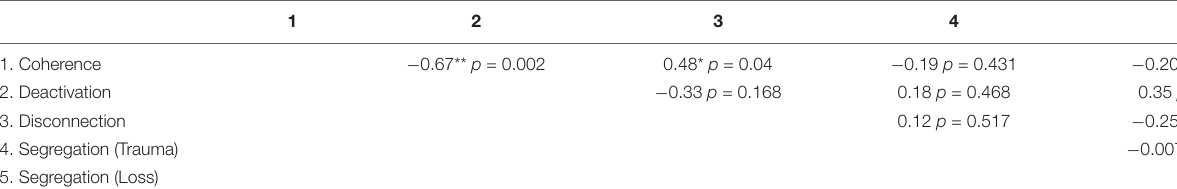
TABLE 3 | Spearman’s correlations (r s ) of coherence of the family discourse with other attachment-related defenses. 1